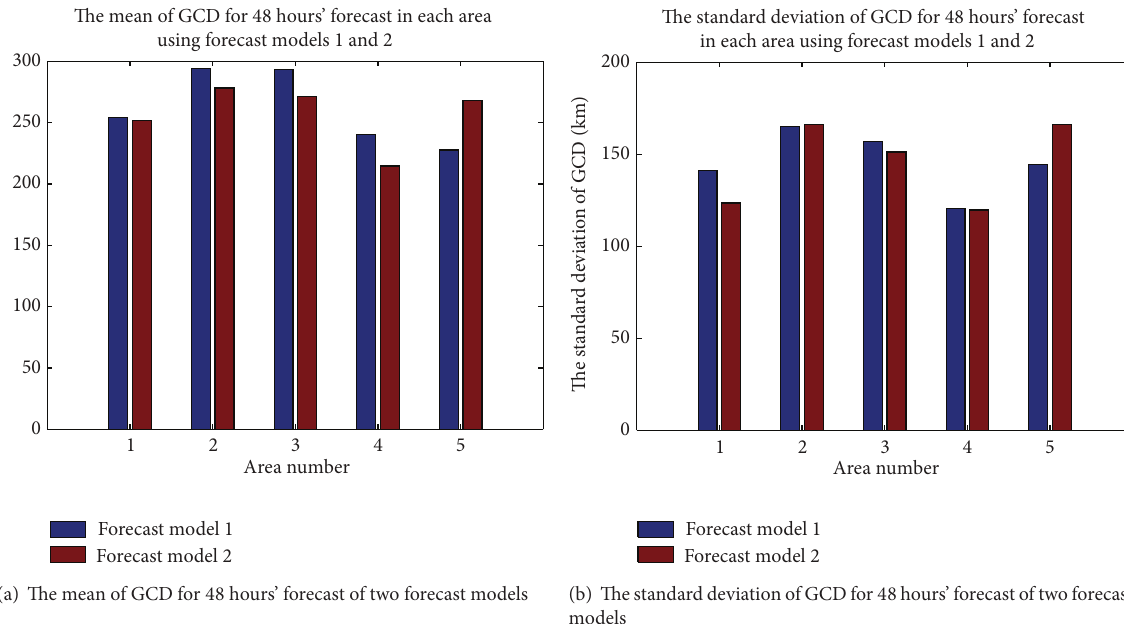
Figure 16: The mean/standard deviation of GCD for 48 hours’ forecast of two forecast